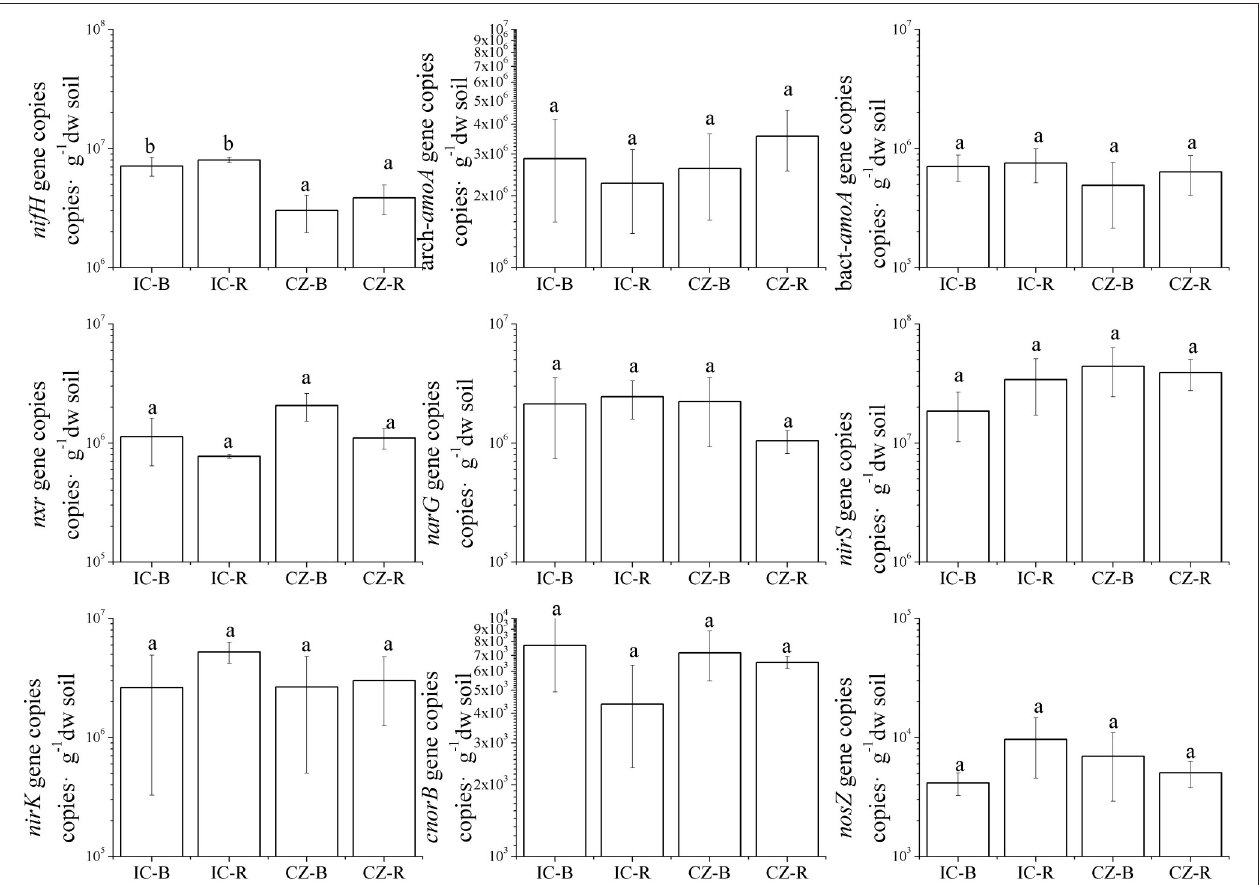
FIGURE 1 | Abundances of genes involved in nitrogen cycling in the rhizosphere and bulk soils of Imperata cylindrica and Chrysopogon zizanioides . Different letters indicate significant differences in samples (LSD, P < 0.05). Samples were bulk tailings of I. cylindrica (IC-B), rhizosphere samples of I. cylindrica (IC-R), bulk tailings of C. zizanioides (CZ-B), and rhizosphere samples of C. zizanioides